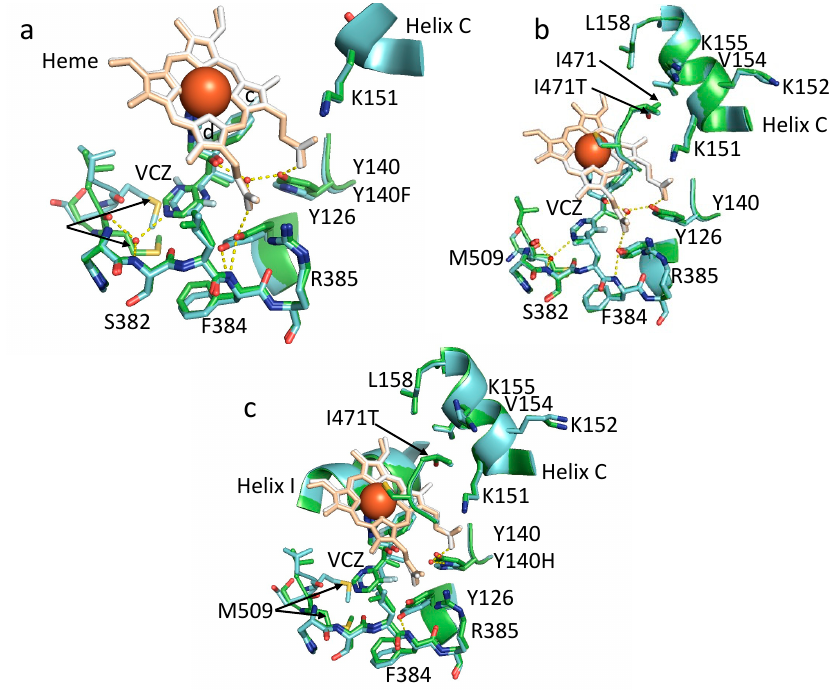
Figure 6. Comparison of the active sites of ScLDM6×His in complex with VCZ. ( a ) ScLDM6×His (carbons in green, heme in wheat, iron as large red sphere) compared with ScLDM6×His Y140H (carbons in azure, heme in white). The hydrogen bond network (yellow dashes) of ScLDM6×His is shown. The LDM Y140H mutation results in the absence of water molecules (small red spheres) within the active site, and the loss of the 2 water-mediated hydrogen bond networks involving VCZ. In ScLDM6×His Y140H, the absence of a water-mediated hydrogen bond involving VCZ and the main chain carbonyl of the M509 gives a significant displacement of this amino acid; ( b ) ScLDM6×His (carbons in green, heme in wheat) compared with ScLDM6×His I471T (carbons in azure, heme in white). The hydrogen bond networks of ScLDM6×His I471T but not ScLDM6×His are shown. The water-mediated hydrogen bond networks found in ScLDM6×His (Figure 6a) are maintained in ScLDM6×His I471T. The hydroxyl of I471T projects into the hydrophobic environment involving the carbon sidechains of K151, V154, K155, and L156 in helix C; ( c ) ScLDM6×His I471T (carbons in green, heme in wheat) compared with ScLDM6×His Y140H I471T (carbons in azure, heme in white). The hydrogen bond network of ScLDM6×His I471T is not shown. In ScLDM6×His Y140H I471T, the single water in the active site is located 3.6 Å from the tertiary alcohol of VCZ, and forms a hydrogen bond network with one nitrogen of the histidine imidazole and the heme ring.